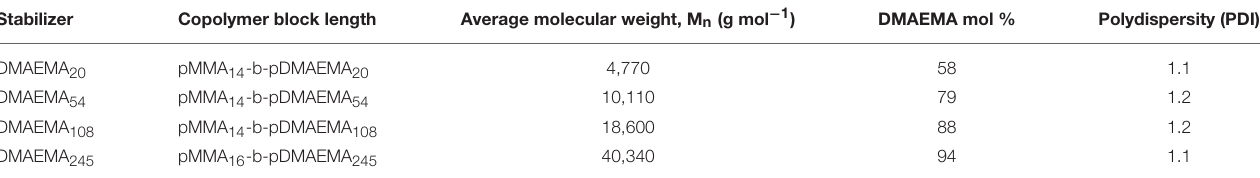
TABLE 1 | Summary of the copolymer block length, molecular weight, and polydispersity of the four pMMA-b-pDMAEMA copolymers used in this study.